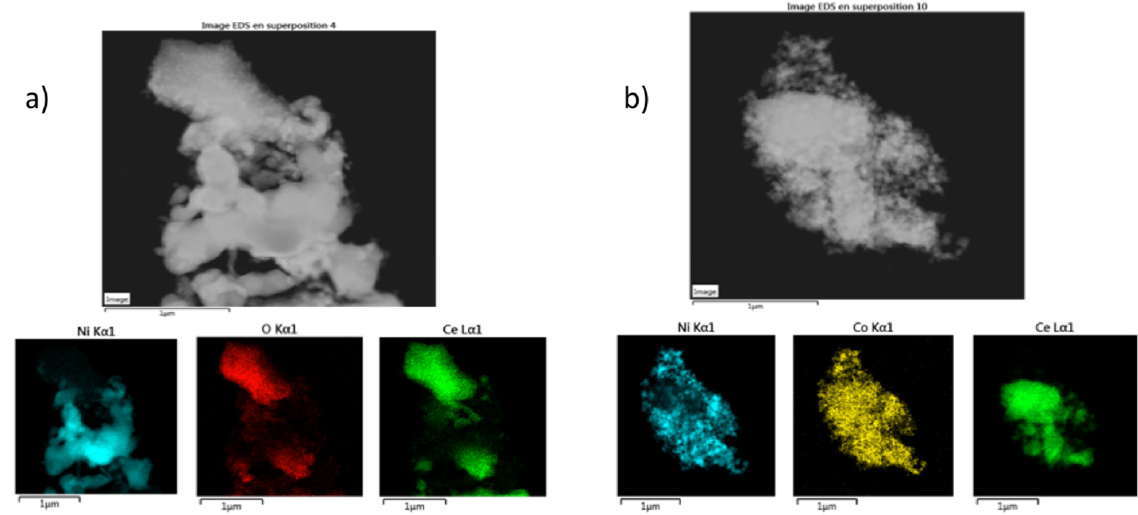
Figure 5. EDS-TEM images of ( a ) Ni/CeO 2 ; ( b ) Co-Ni/CeO 2 after reduction.